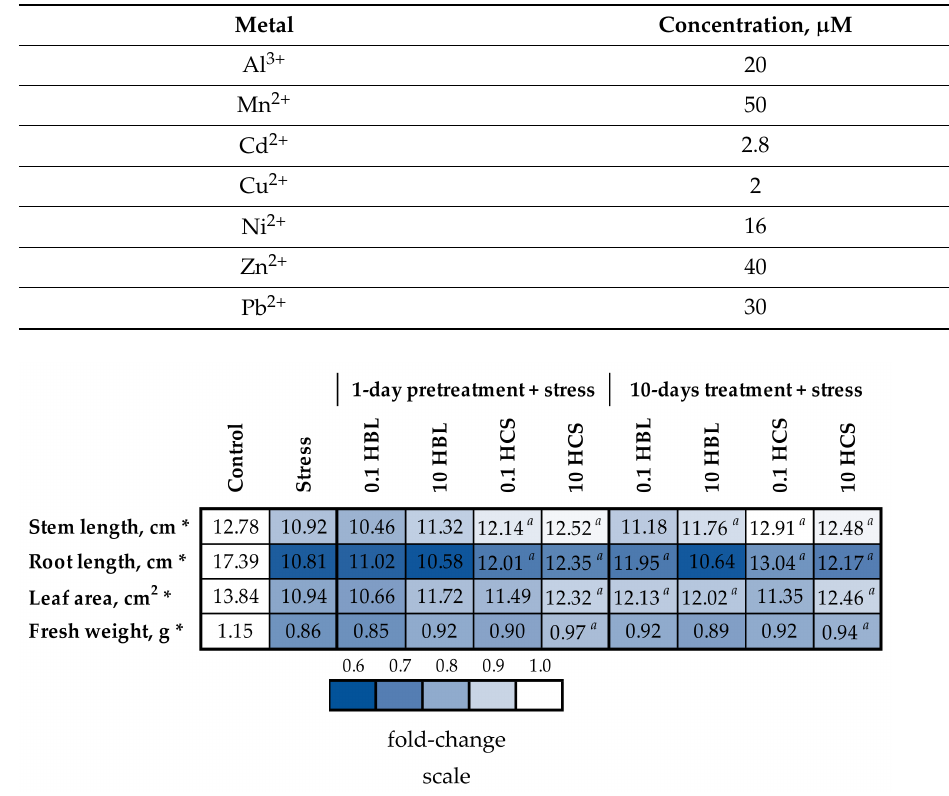
Figure 2. The effects of heavy metal stress and treatment with brassinosteroids on the growth parameters of barley plants. The value in the control plants was taken as 1.0, and the relative decrease is indicated in blue. Here and below: For description of experimental variants, see Materials and methods. Pairwise comparisons of the means were performed using Student’s t -test. Asterisks (*) indicate significant differences from the control variant, and the a letter indicates significant differences from the polymetallic stress-treated variant ( p <